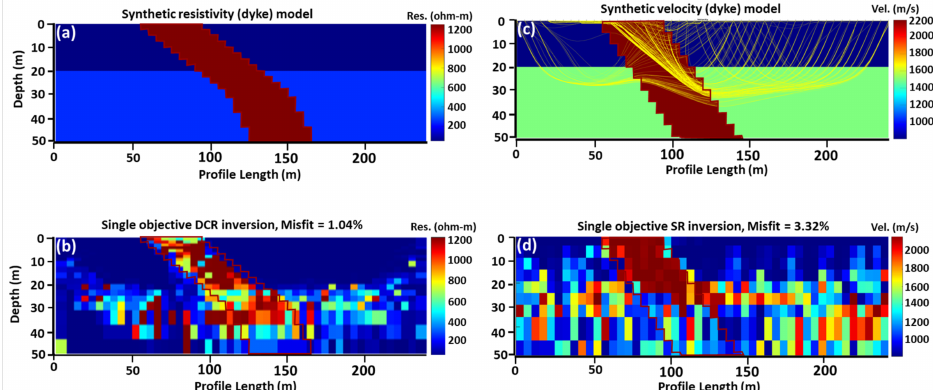
Figure 11. Dyke anomaly model inversion using the single objective global optimization method; ( a ) synthetic dc-resistivity model, ( b ) single object inverted resistivity model, ( c ) synthetic velocity model, and ( d ) single objective inverted velocity model. The dark red line is used to mark the anomaly boundary.